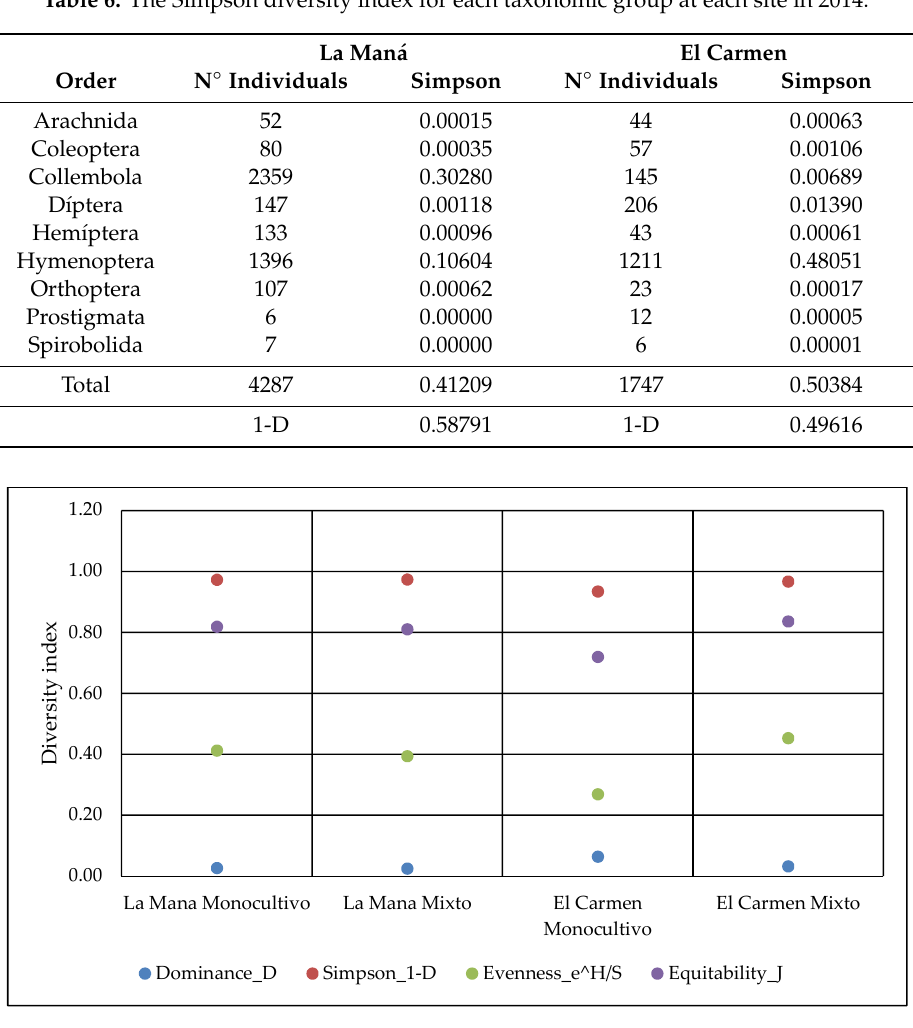
Figure 1. Simpson diversity index (1-D) and its three components; Dominance (D), Evenness (eˆH / S) and Equitability (J) in function of the agroecosystem and locality, considering the amount of arthropods